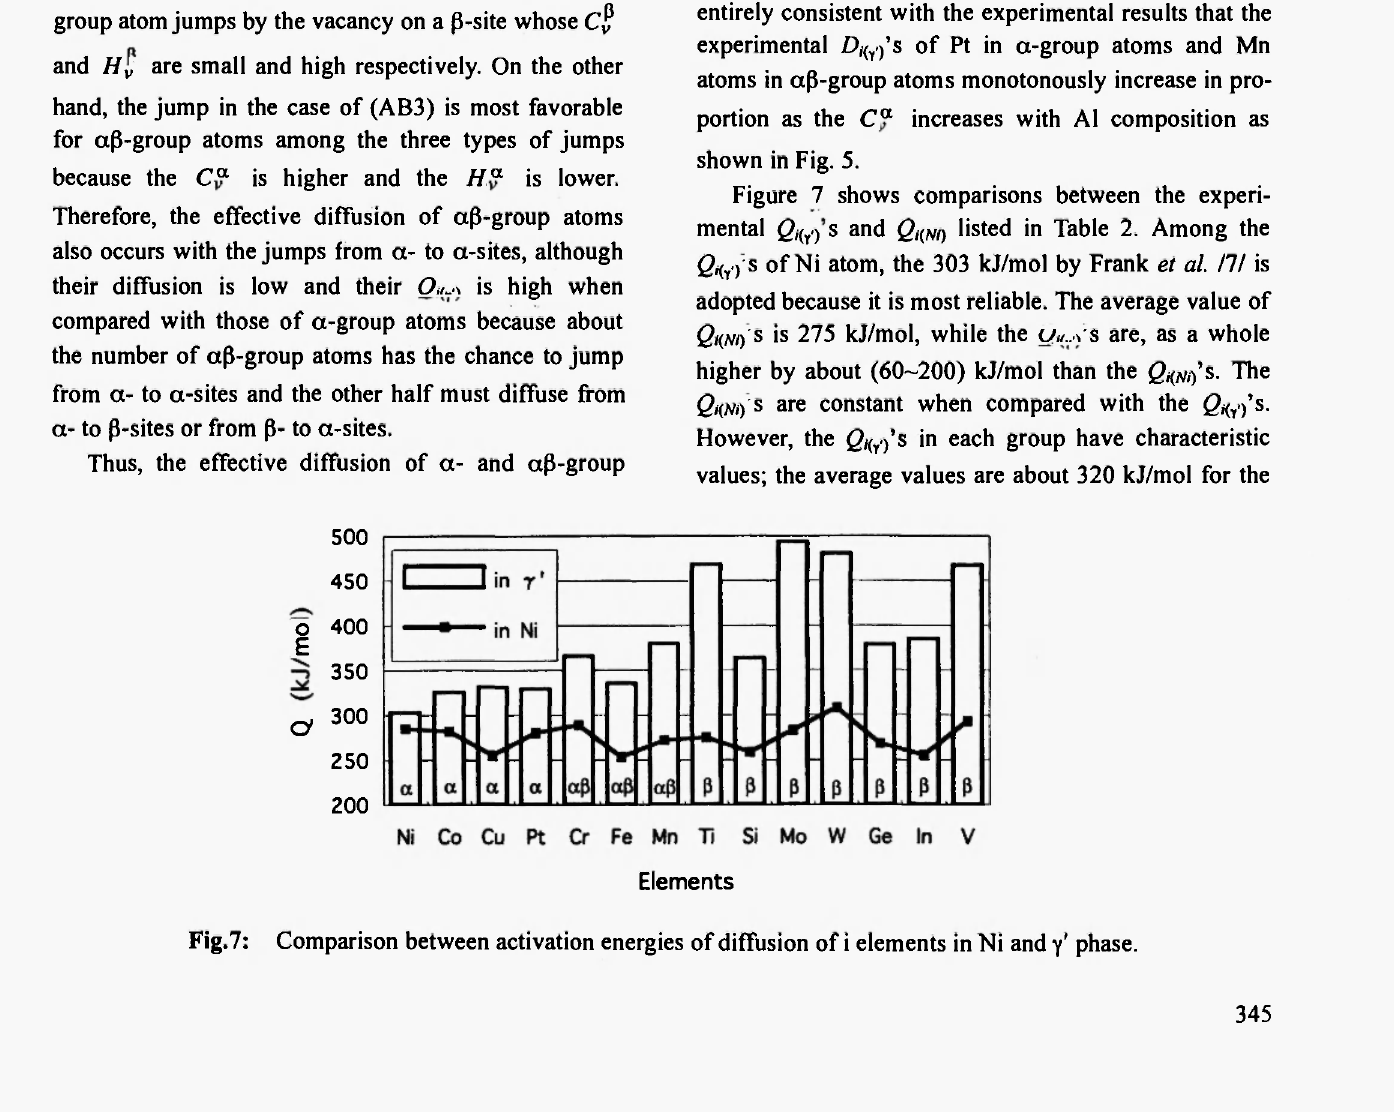
Fig. 6: Arrangements of the atoms in the nearest neighbor sites for (a) Al and (b) Ni atoms.